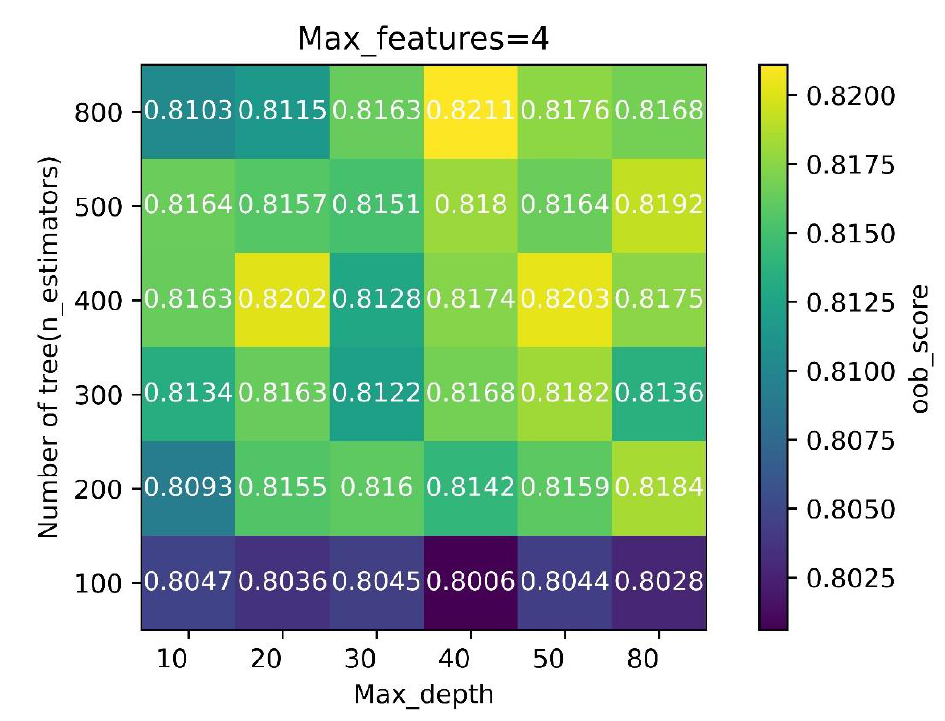
Figure 2. Effect of total number of trees in the forest (n_estimators) and maximum depth of the trees (max_depth) on OOB scores in determining RF CP classification models (with random-split predictor variables, max_features, set at 4).